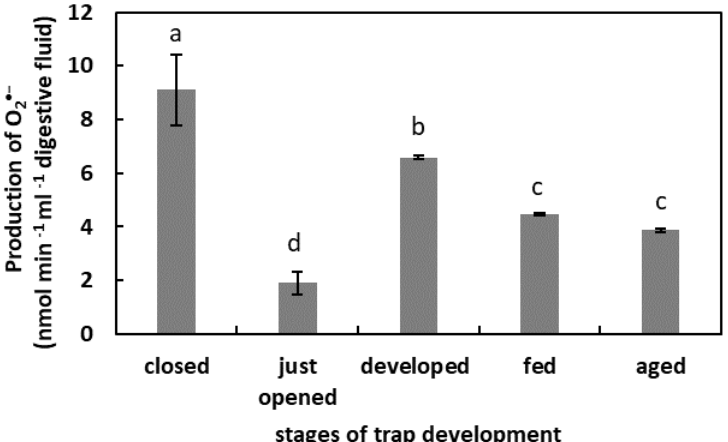
Figure 1. Superoxide anion (O 2 •− ) production in digestive fluid in the traps at different developmental stages: closed, just opened, developed, fed (one day after feeding), and aged. Values are average ± SD of 3 repetitions. Letters (a–d) indicate homogenous groups determined after ANOVA and post hoc Fisher’s LSD test at p ≤